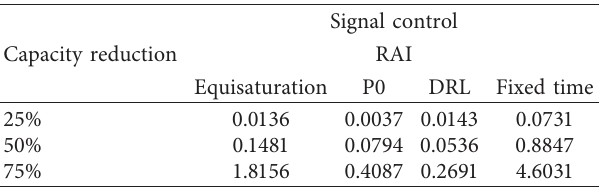
Figure 7: Evolution of route costs, route flow, and total cost evolution under different levels of disruptions when the fixed time signal control is employed. First row (from (a) to (c)): the evolution of route costs, route flow, and total cost when the capacity of link 9 reduces by 25%; second row (from (d) to (f)): the evolution of route costs, route flow, and total cost when the capacity of link 9 reduces by 50%; third row (from (g) to (i)): the evolution of route costs, route flow, and total cost when the capacity of link 9 reduces by 75%. Table 4: RAIs under different levels of disruptions with different signal